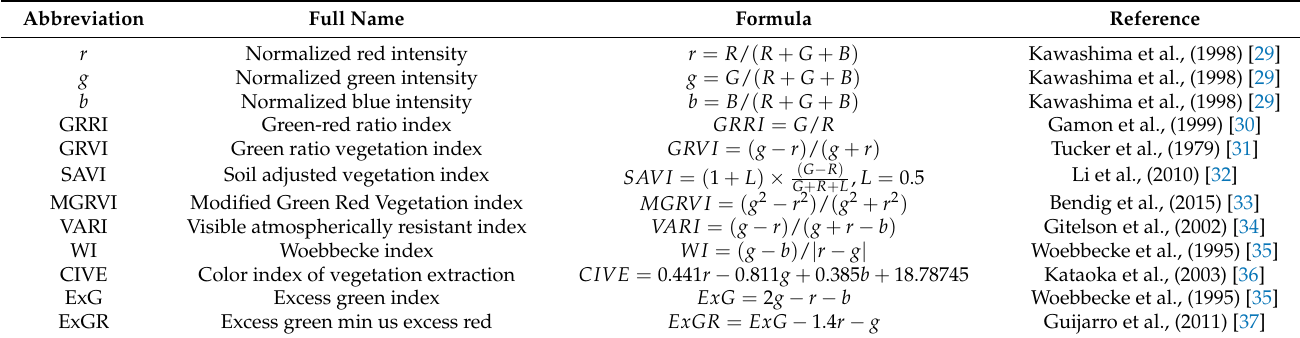
Table 4. Characteristic bands or vegetation indices used in this